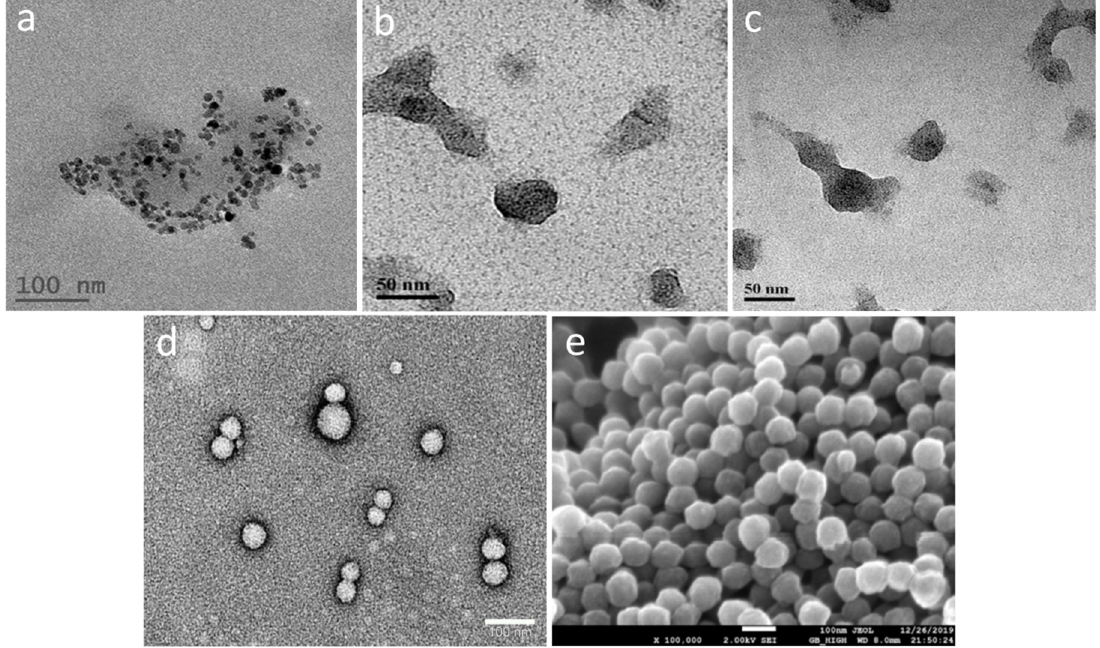
Figure 2. Micrographs of PLGA- Су 5 NP and hMNP-FITC obtained by SEM and TEM: ( a ) TEM image of hMNP without staining; TEM images of hMNP-FITC ( b ) and hMNP-Cy3 ( c ) stained with uranyl acetate (Tecnai G2 microscope, FEI –Teramo fisher); ( d ) TEM images of PLGA-Cy5 NP (JEOL JEM-1400); ( e ) SEM image of PLGA- Су 5 NP (sputter-coated with Pt, JSM-7600F Schottky field emission scanning electron microscope, JEOL, Japan) .